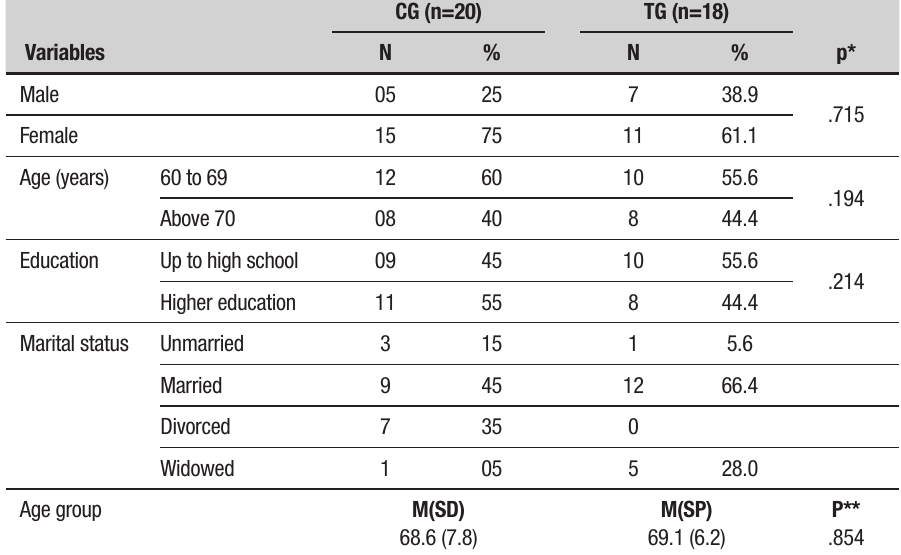
Table 2. Descriptive sociodemographic data of the 38